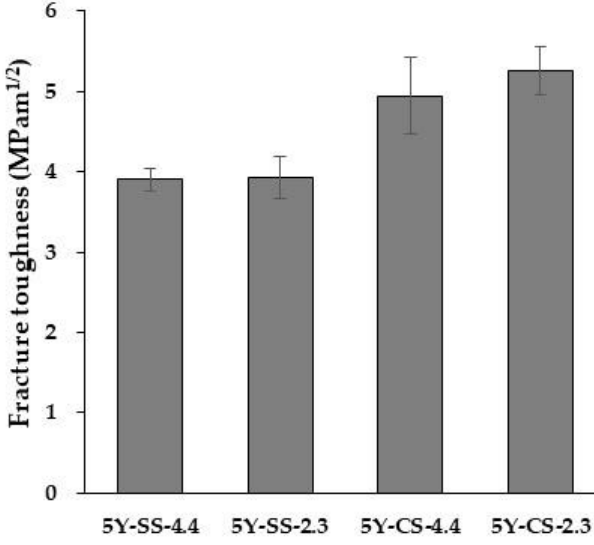
Figure 12. Tree-point flexural strengths of 5Y-SS and 5Y CS.